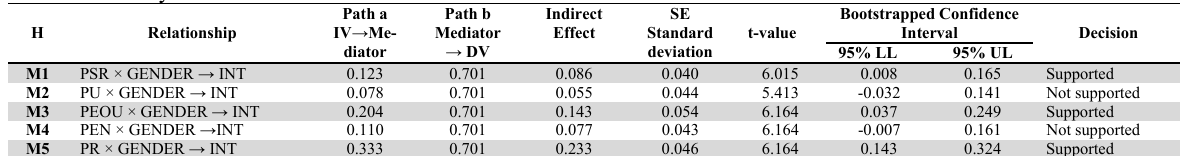
Moderator Analysis